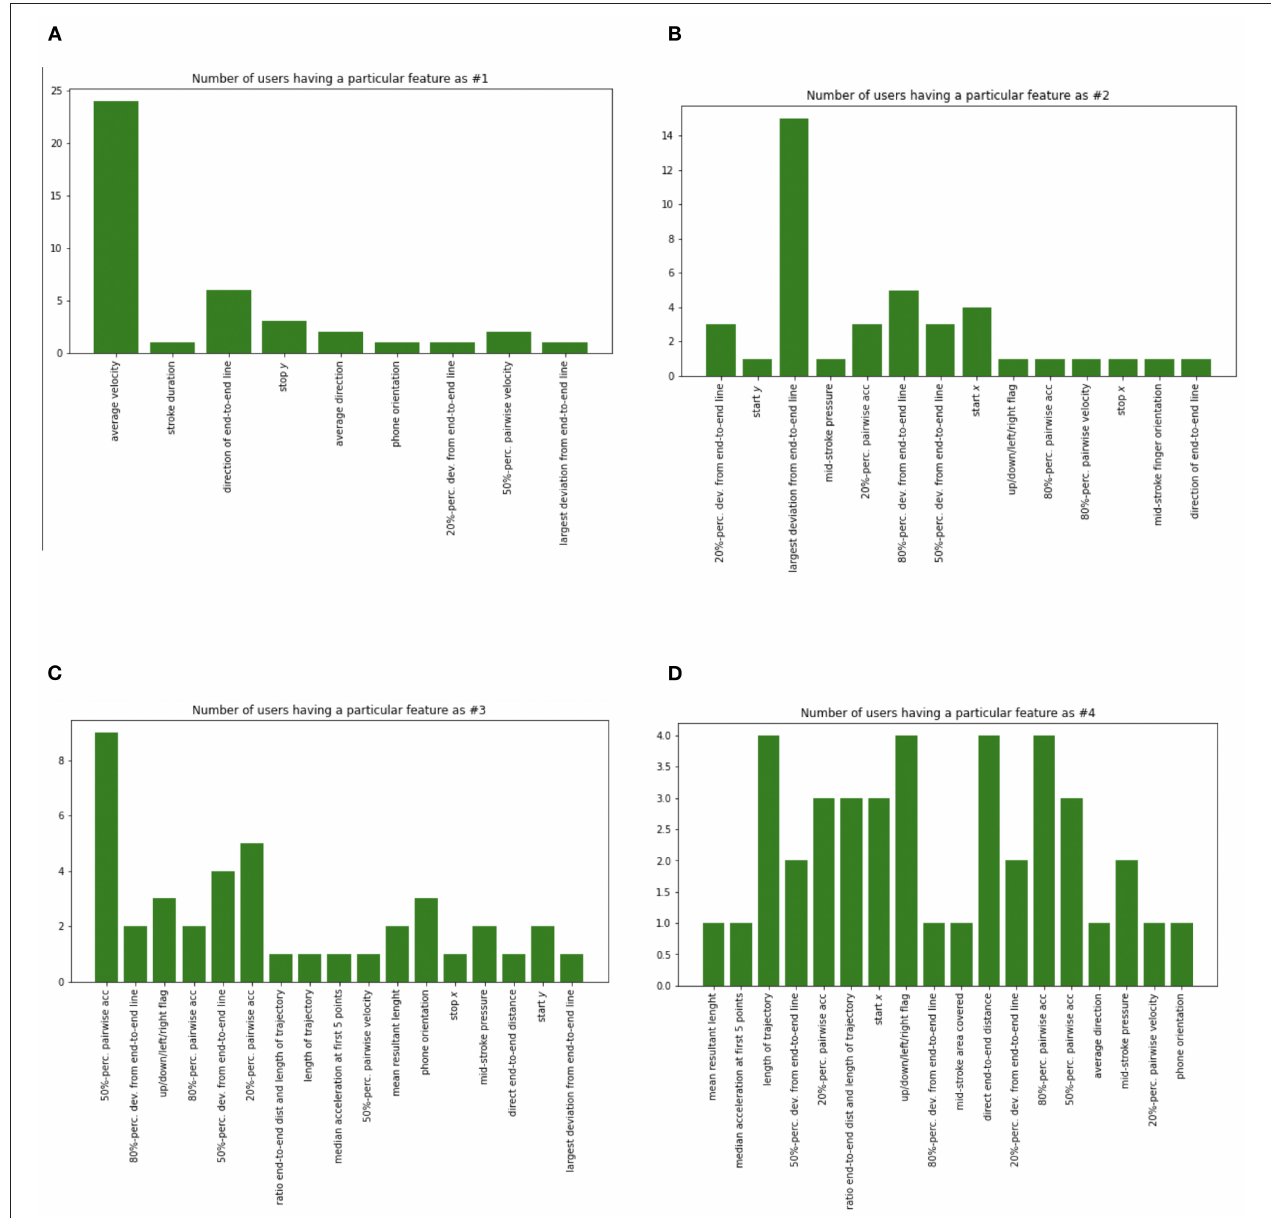
FIGURE 10 | Four histograms of the number of users for a particular feature. “Average velocity” of finger swiping is the dominant feature across subjects. The next dominant feature is “largest deviation from end to end line”. In all histograms (A–D) , the distribution becomes flattened consistent with equal error rate decline across all users. The feature designations were given in Frank et al. (2013), from whose database these features were extracted for this